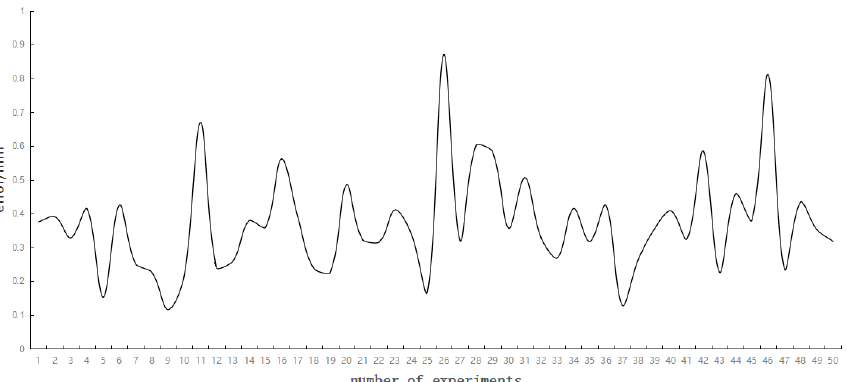
Figure 12. Laser spot error distribution of the calibration result points (average of every 20 groups).